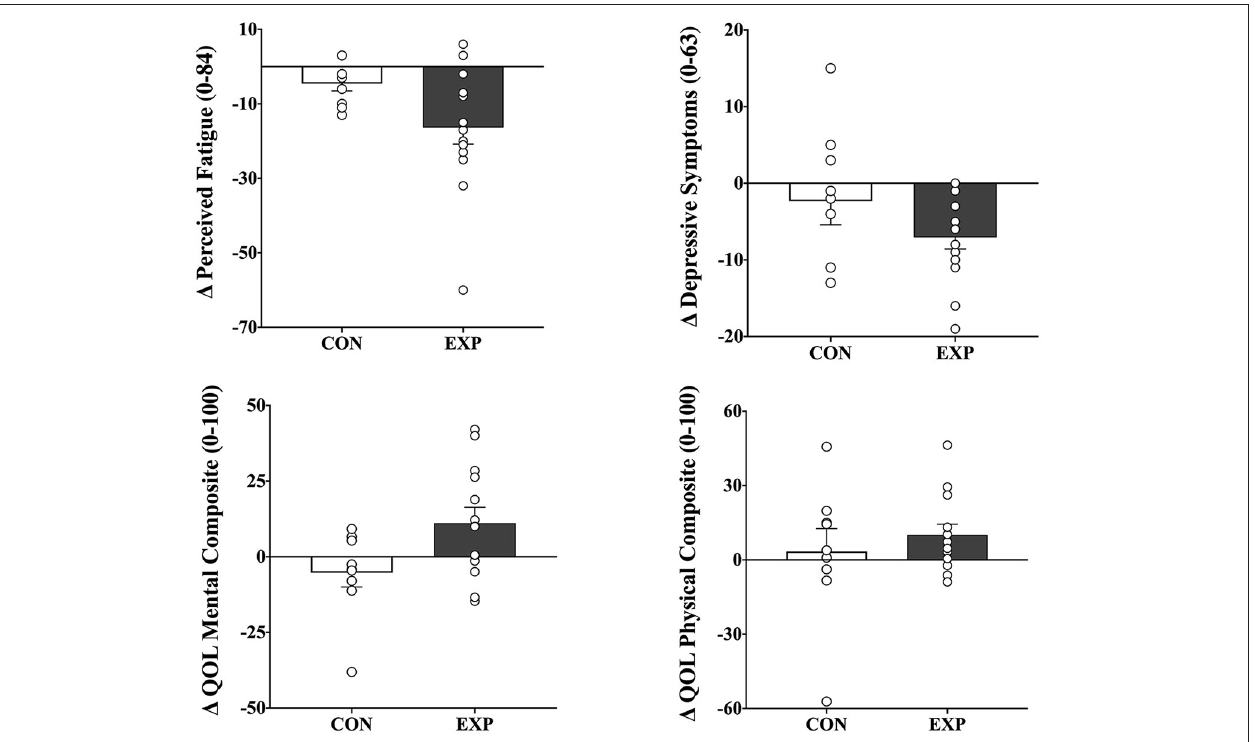
FIGURE 3 | Mean and individual change scores in perceived fatigue ( top left ), depressive symptoms ( top right ), and both mental-( bottom left ) and physical-( bottom right ) composites of health-related quality of life after combined endurance and resistance training for both control ( CON ; n = 9) and experimental ( EXP ; n = 9) groups. The values are post- minus pretraining (means ± SEM ). There were no significant differences between